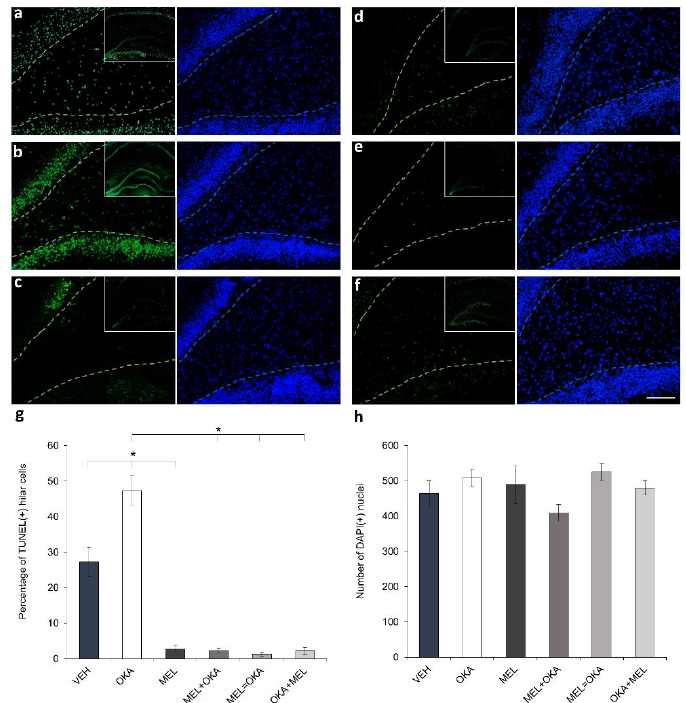
Figure 3. Assessment of the effect of okadaic acid and melatonin on DNA fragmentation in hilar hippocampus. Treated rat hippocampal organotypic slices (400 µ m) were fixed as described in methods section and 50 µm cryosections were processed to detect DNA fragmentation by TUNEL fluorometric assay (shown in green) and to counterstain nuclei with DAPI (shown in blue). Representative fluorescent images of treated slices are depicted as follow s : ( a ) vehicle (VEH), ( b ) 45 nM okadaic acid (OKA), ( c ) 100 nM melatonin (MEL), ( d ) MEL before OKA, ( e ) simultaneous MEL and OKA, ( f ) OKA before MEL; hilar hippocampus is delineated with a discontinuous line (TUNEL in green and DAPI in blue). Upper right corner inserts depict TUNEL-staining of the whole hippocampus. Panel ( g ) shows the analysis of TUNEL(+)-cells as percentage regarding the total nuclei. Panel ( h ) represents the total number of nuclei counterstained with DAPI. Data represent the mean ± SEM and statistical analysis was performed with ANOVA on Ranks before Student-Newman-Keuls test for multiple comparisons. * depicts p < 0.05. Scale bar in ( f ): 100 µm.